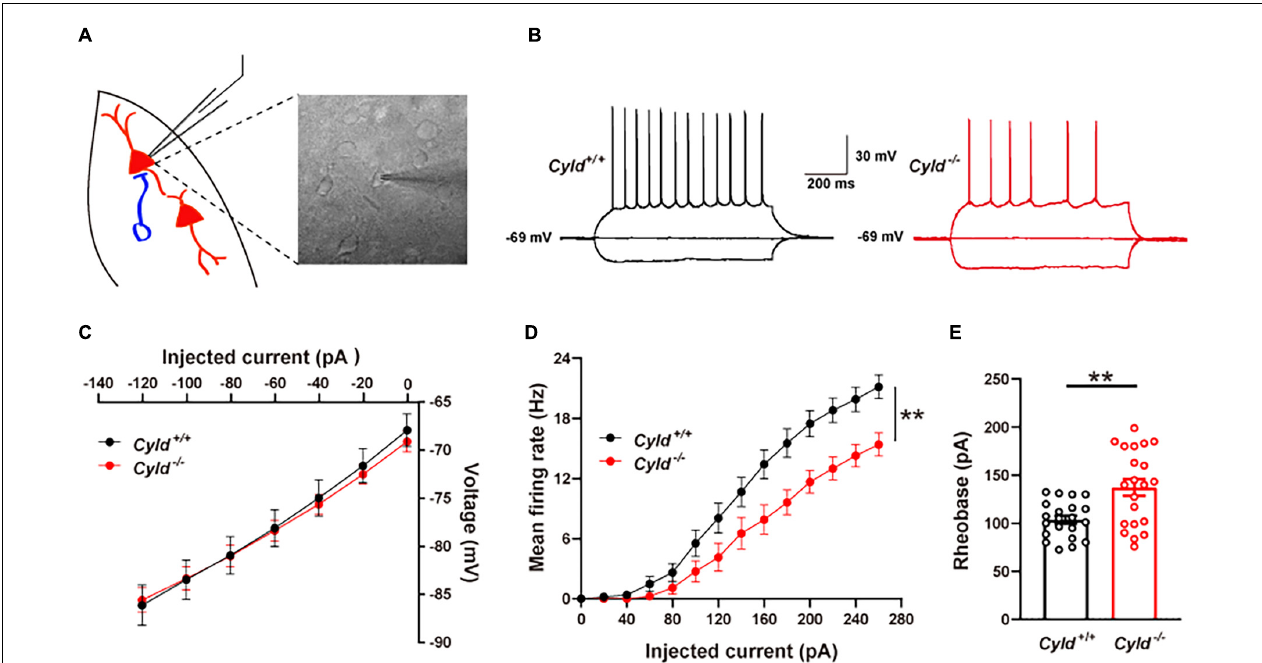
FIGURE 3 | Reduced intrinsic excitability of the principal neurons in the BLA of Cyld − / − mice. (A) Recording diagrams of the patch-clamp experiment. Pyramidal neurons in the BLA of acute brain slices from Cyld − / − and Cyld + / + mice were recorded in a whole-cell configuration. (B) Representative AP traces evoked by the hyperpolarized current (-120 pA) and depolarizing current (120 pA) injection. (C) Similar current–voltage characteristic curve of the principal neurons in the BLA of Cyld − / − and Cyld + / + mice. n = 21 neurons from seven mice for each genotype. (D) Principal neurons from the BLA of Cyld − / − mice exhibited a lower number of APs in response to current injections ranging from 0 to 260 pA in steps of 20 pA. n = 21 neurons from seven mice for each genotype. (E) A higher rheobase current was needed to elicit an AP in Cyld − / − mice. n = 21 neurons from seven mice for each genotype; Student’s t -test, ** p < 0.01. Data are presented as mean ± SEM.